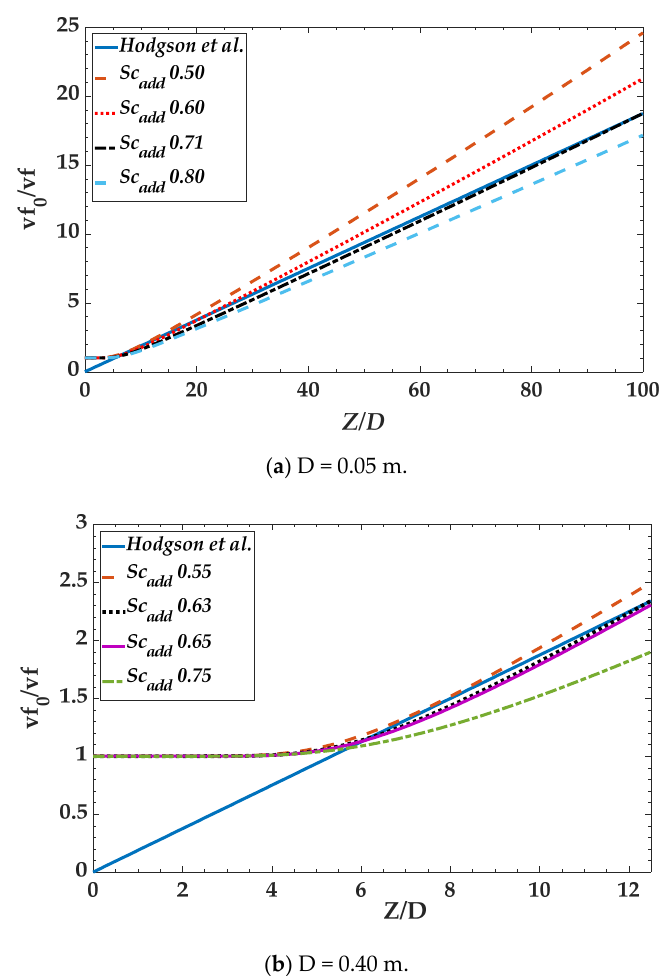
Figure 6. Relationship between volume fraction ratio ( vf 0 / vf ) and dimensionless distance ( Z / D ) under different turbulent Schmidt numbers of additional variable.